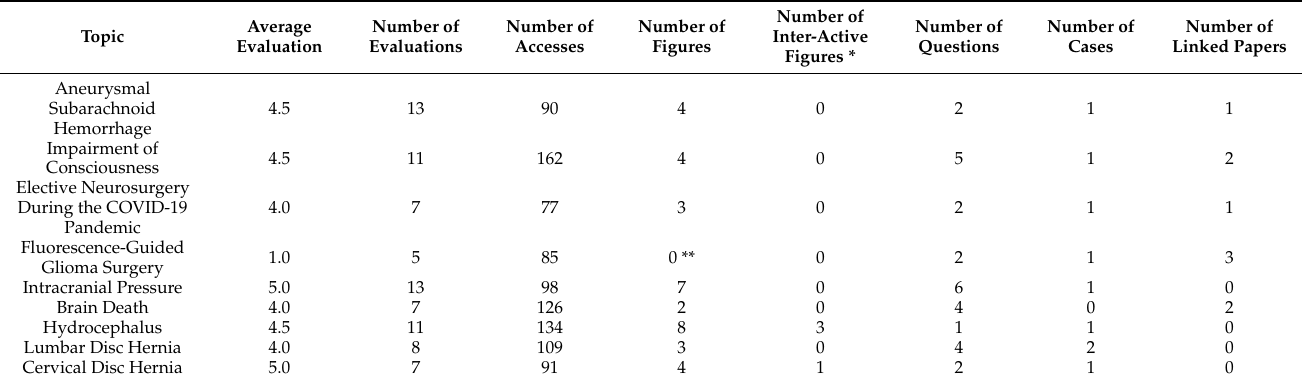
Table 1. Characteristics of 9 digital teaching